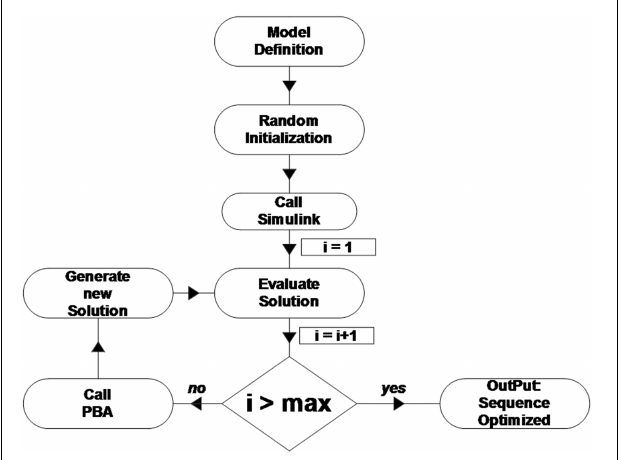
FIGURE 5 | Indicative flowchart of the proposed